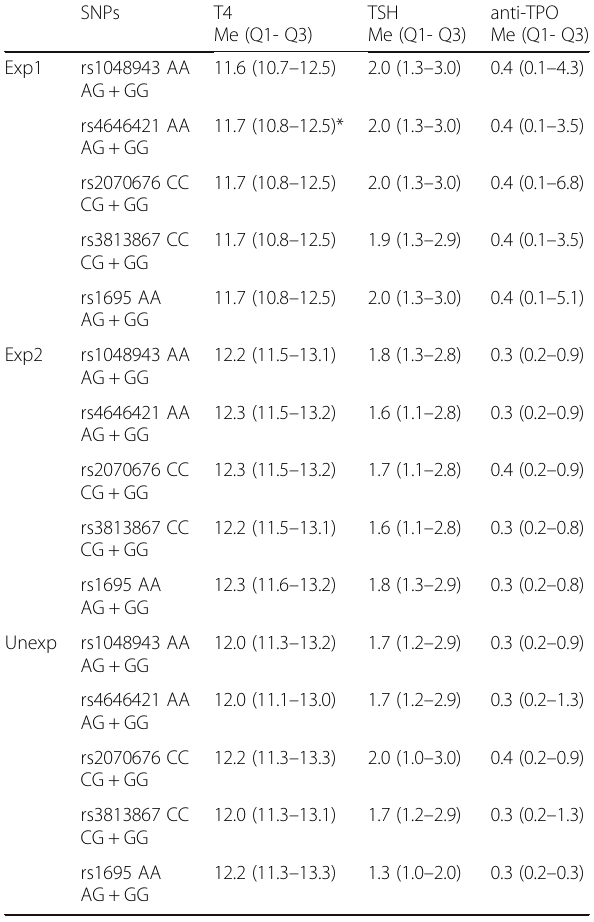
Table 3 The Association between Genotypes and Thyroid Hormone Parameters in the Studied Population